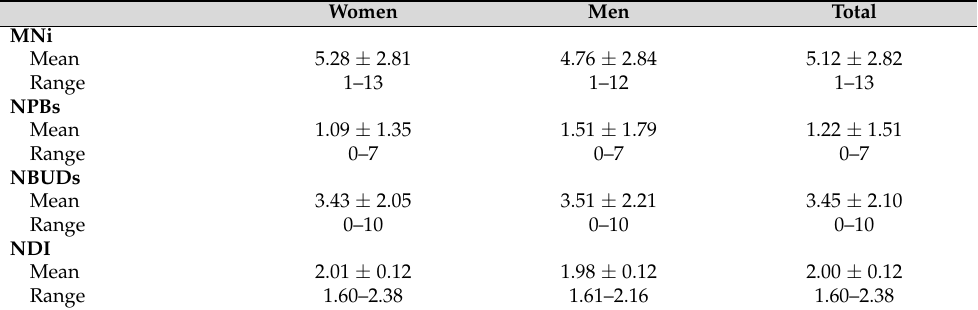
Table 2. Mean values ± standard deviation of the cytokinesis-block micronucleus (CBMN) assay parameters (total number of micronuclei, nucleoplasmic bridges, nuclear buds per 1000 cells, and nuclear division index) in peripheral blood lymphocytes of the general